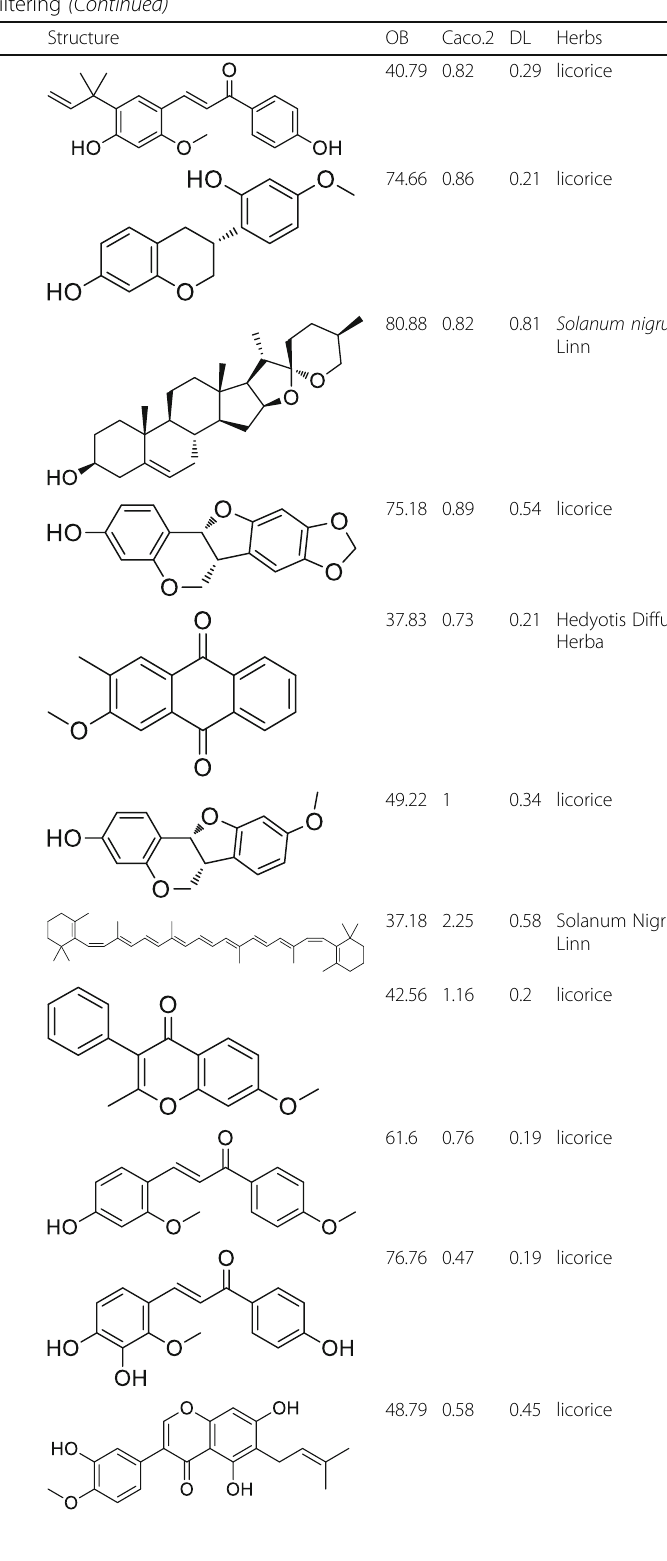
Table 1 Information of active compound by ADME filtering